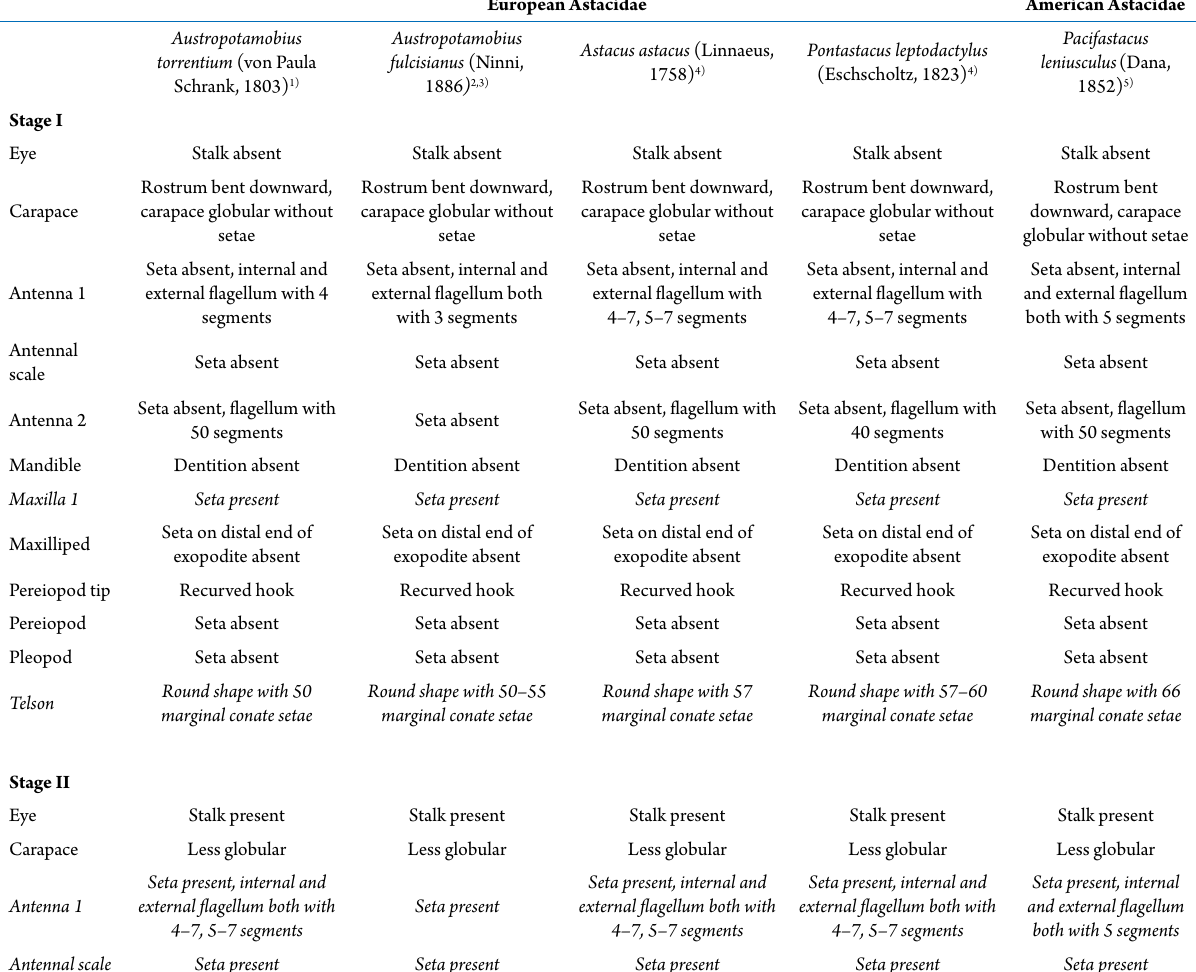
Table 1. Comparison of the morphology of postembryonic stages of European Astacidae and American